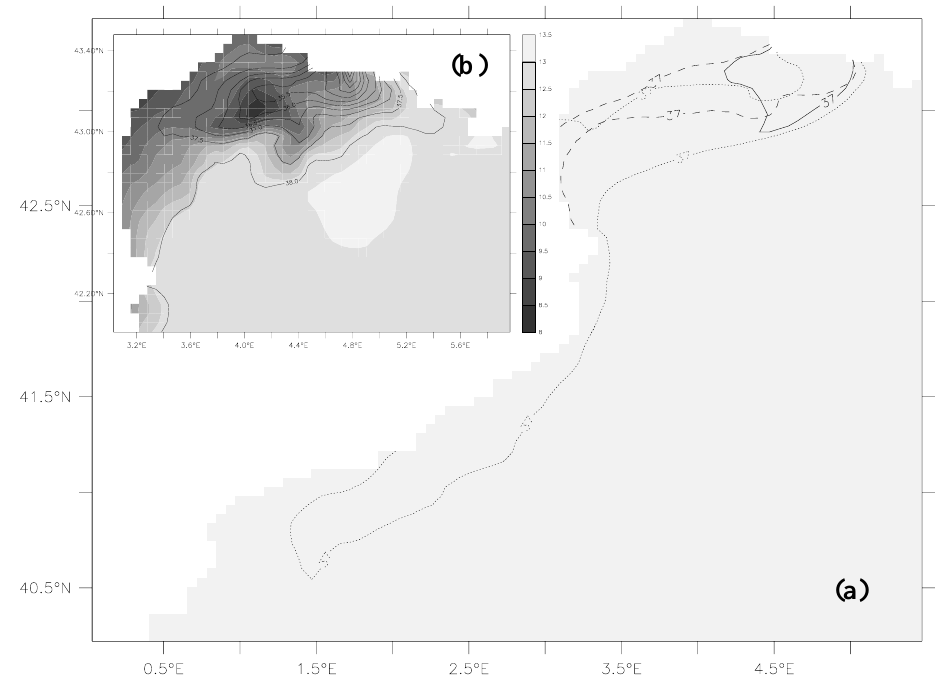
Fig. 12. (a) Extension of the fresh surface waters (delimited by the 37PSU isohaline) in January (full line), March (dashed line), July (dotted line) of year II. (b) Sea-surface temperature (shaded, values between 8 ◦ C and 13.5 ◦ C at intervals of 0.5 ◦ C) and salinity (isohalines between 33 and 38PSU at intervals of 0.5PSU ) in February, year